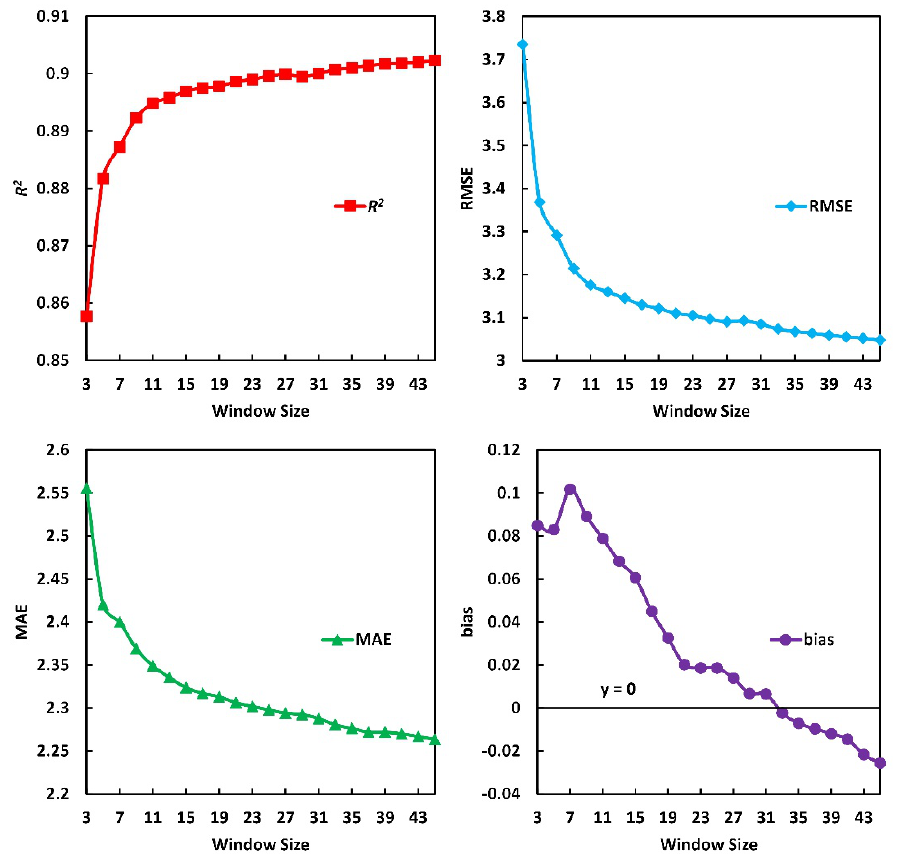
Figure 9. Analysis the optimal size (pixels) of the window used for the spatial filling method illustrated in Figure 10.